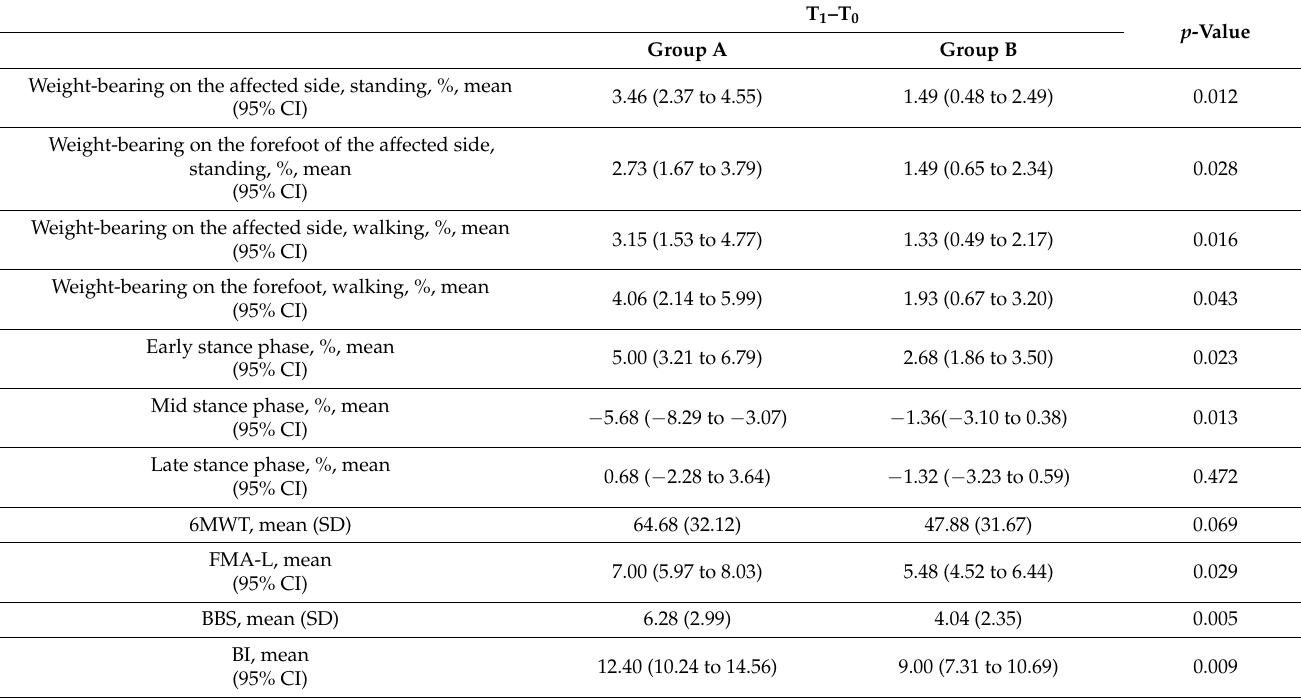
Table 4. Results of the secondary